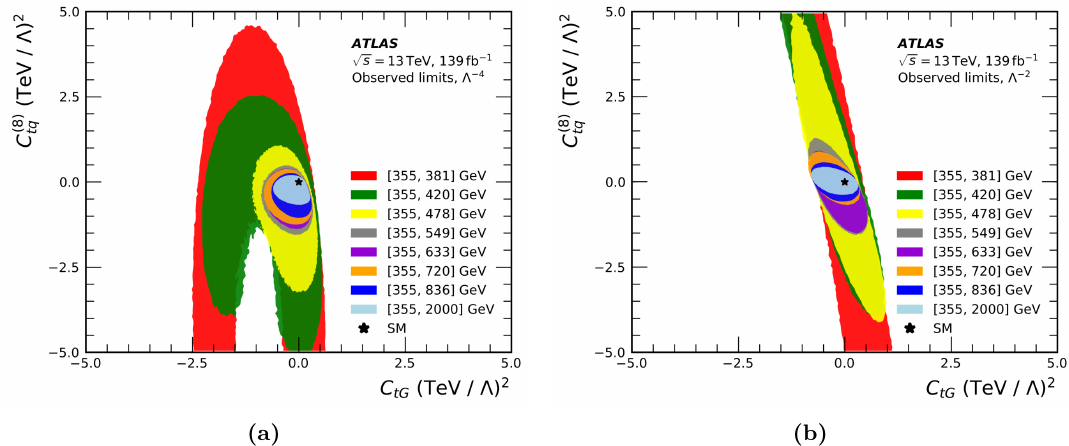
Figure 21. Evolution of the 95% observed credible region when adding the bins of the measured distribution to the interpretation one-by-one for (a) the Λ − 4 model and (b) the Λ − 2 model. The p t,h T coloured ellipses show the 95% regions obtained from fitting the p t,h